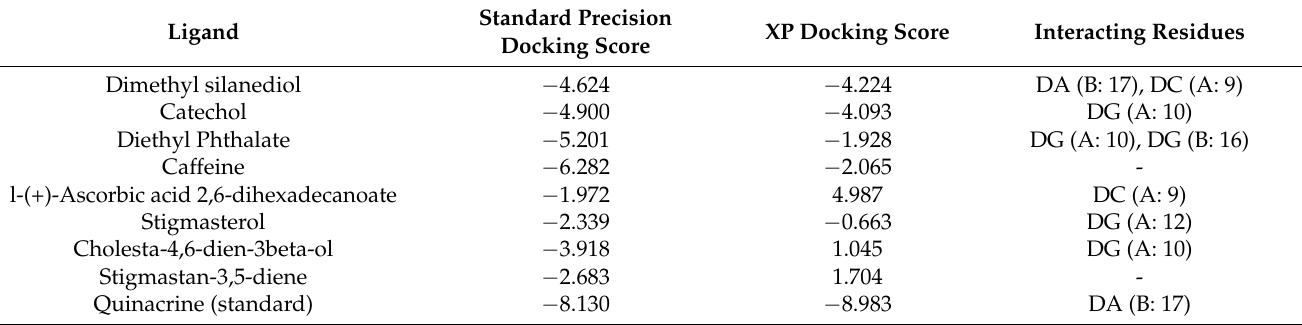
Table 7. Molecular modeling and interaction profiles of identified compounds and DNA.